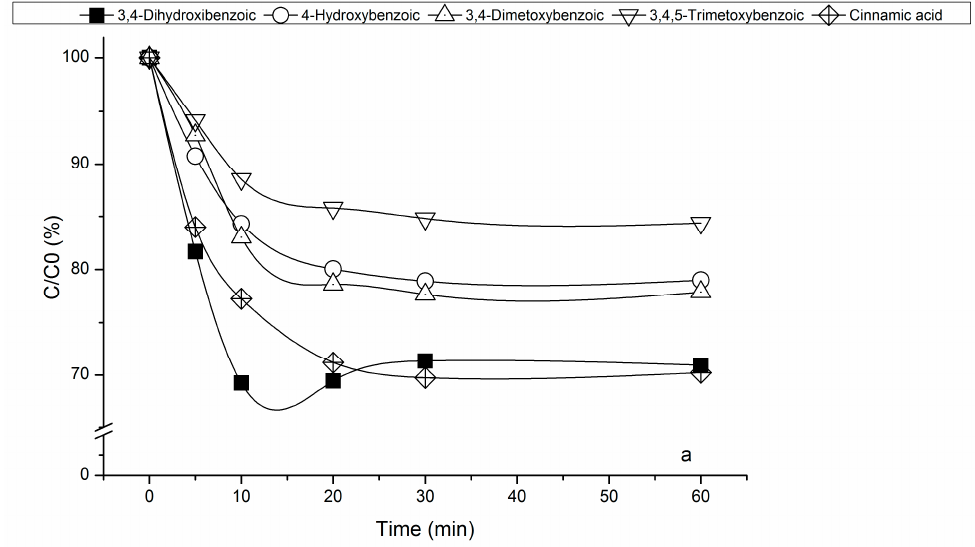
Figure 3. Normalized concentration of phenolic acids throughout the process of Fenton (H 2 O 2 ) = 50 mg/L; RM = 1 g/L; pH = 3.4).